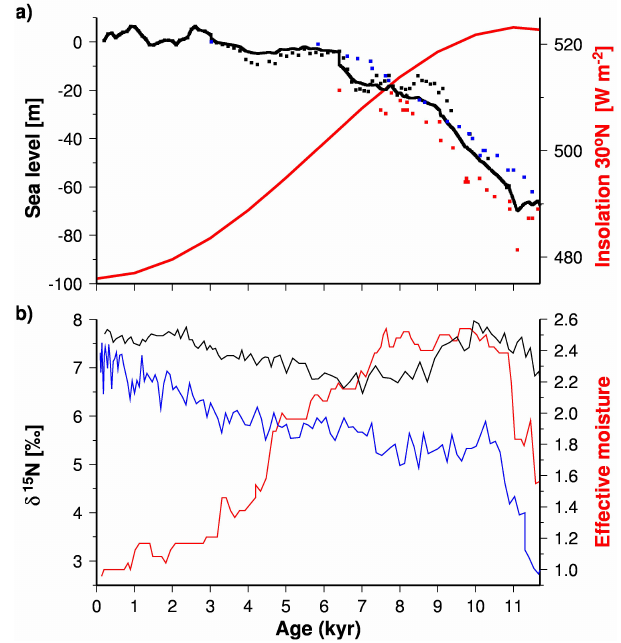
Figure 10. (a) Holocene sea level changes obtained from Sidall et al. (2003, black squares), Fairbanks (1989, blue squares), Bard et al. (2000, red squares), and Arz et al. (2007, red squares). The black line is the mean calculated from all data points. The blue curve shows the solar insolation at 30 ◦ N obtained from Berger and Loutre (1991). (b) The red curve reveals the central Asian effective mois- ture index, representing monsoon strength (Herzschuh, 2006). The black line shows the δ 15 N record from the core RC27-23 (Altabet et al., 2002) and the blue curve reveals the δ 15 N records from the core MD-04 2876 (Pichevin et al.,